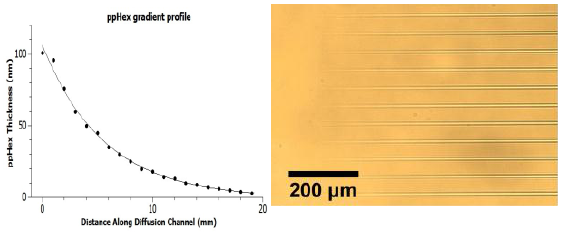
FIGURE 2: Thickness of the ppHex film decreases as an exponential decay along the diffusion channel.